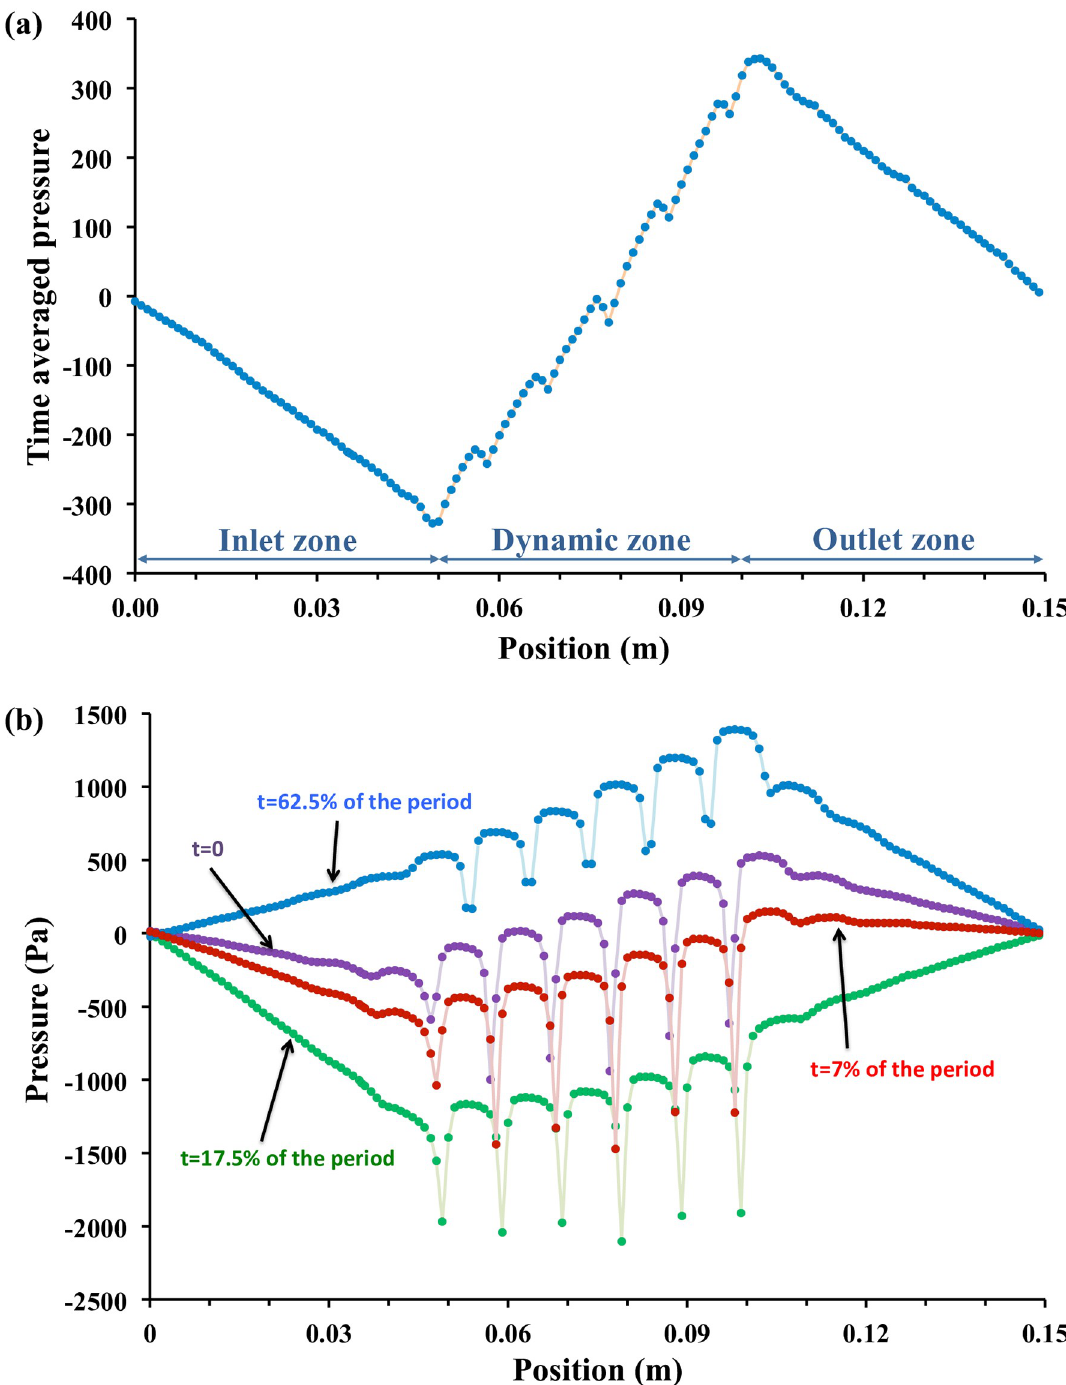
Fig 4. Pressure profiles. (a) Time averaged pressure profile along the main flow axis (b) Instantaneous profiles at various points of time. The dips on the profile correspond to the constriction zone. Imposed pressure difference Δ P